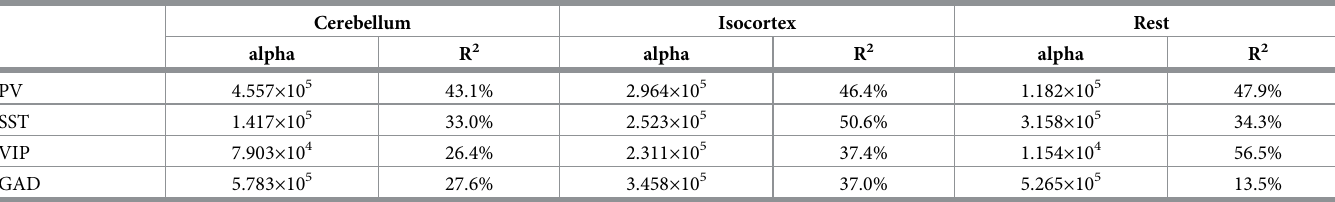
Table 2. Results of the linear